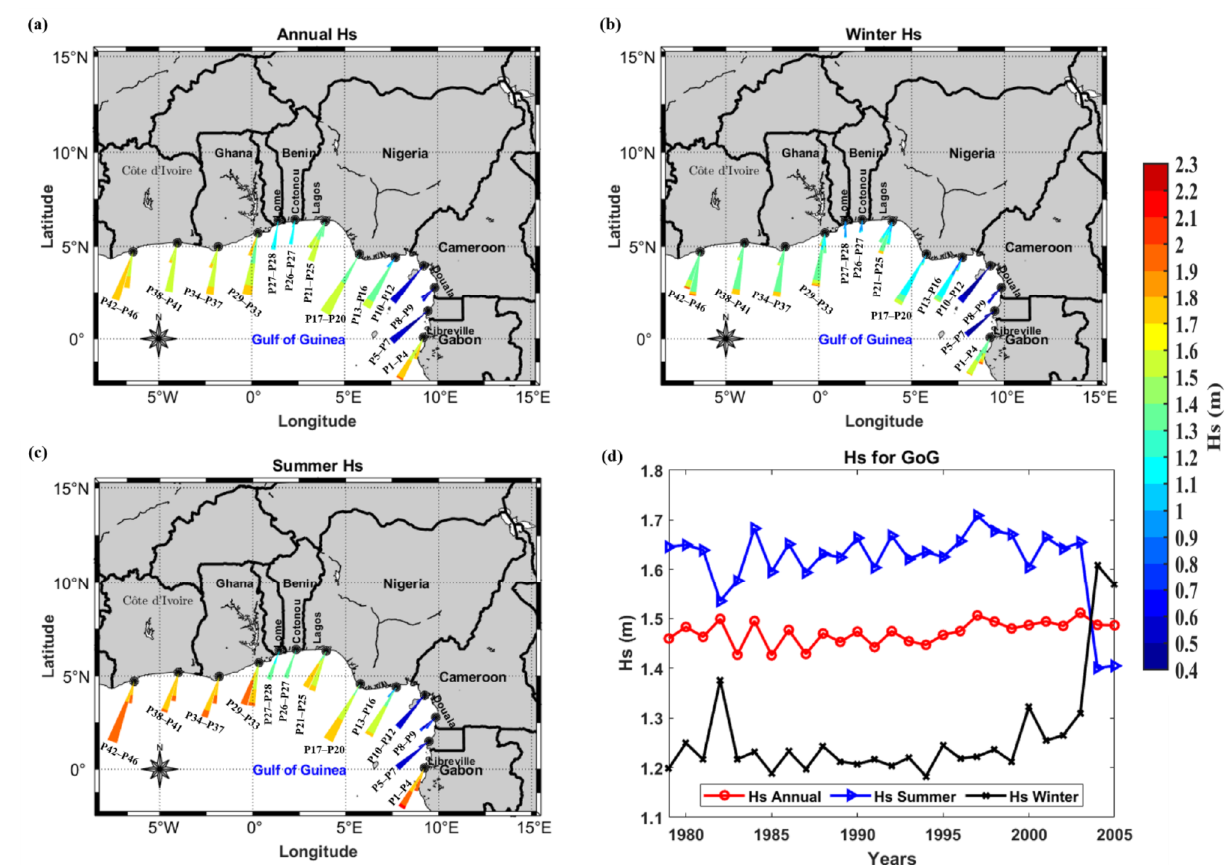
Figure 2. Wave roses showing direction-oriented spatial distribution of the average ( a ) extreme annual Hs ( b ) extreme winter Hs ( c ) extreme summer Hs and ( d ) timeseries of Hs between 1979–2005.